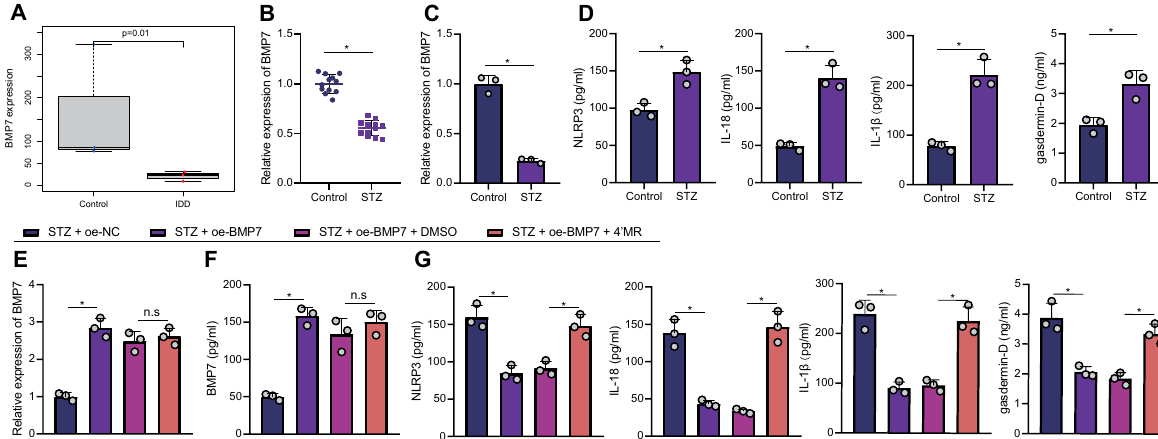
Fig. 6 Effect of BMP7 on the IDD of T1DM rats by regulating NLRP3 inflammasome activity and pyroptosis of NPCs. A BMP7 expression in the transcriptome sequencing data of T1DM‑induced IDD rats. Control (normal rats) n 3, STZ (T1DM‑induced IDD rats) n 3. B BMP7 expression in = = the NP tissues of STZ‑induced T1DM rats measured by RT‑qPCR. C BMP7 expression in the NPCs isolated from STZ‑induced T1DM rats measured by RT‑qPCR. D Levels of pyroptosis‑related proteins in NPCs and cell supernatant measured by ELISA. E BMP7 expression in NPCs from STZ‑induced T1DM rats transduced with oe‑BMP7 and treated with 4’MR determined by RT‑qPCR. F BMP7 levels in NPCs and cell supernatant from STZ‑induced T1DM rats transduced with oe‑BMP7 and treated with 4’MR measured by ELISA. G Levels of pyroptosis‑related proteins in NPCs from STZ‑induced T1DM rats transduced with oe‑BMP7 and treated with 4’MR measured by ELISA. n 12. * p < 0.05. n.s. indicates not significant. Data are shown as = the mean standard deviation. Data between two groups were compared by unpaired t ‑test, and data comparisons among multiple groups were ± analyzed by the one‑way ANOVA with Tukey’s post hoc test. The cell experiment was repeated three times